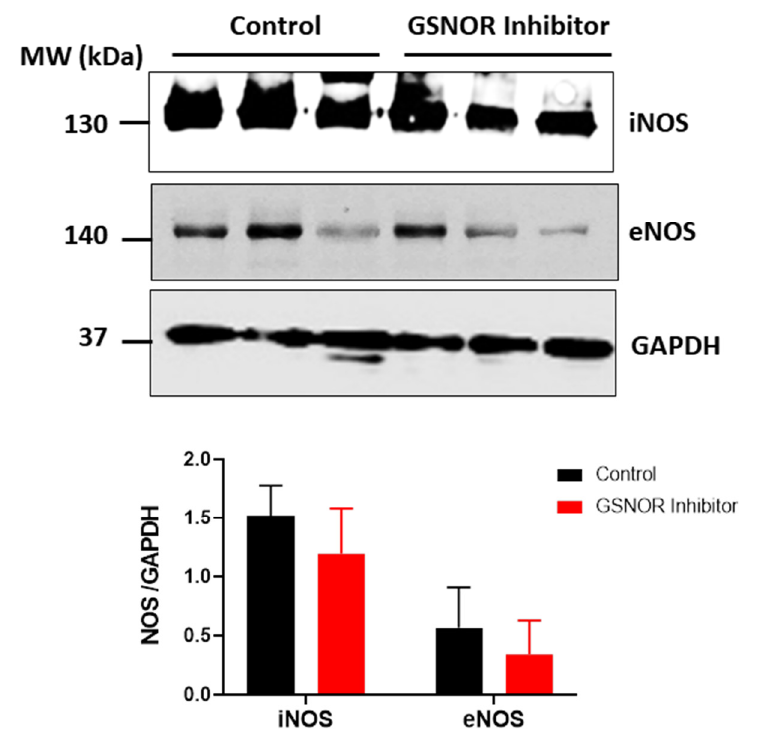
Figure 5. Expression of nitric oxide synthase (NOS) isoforms. Western blot analysis for the expression of inducible (iNOS) and endothelial (eNOS) NOS in the rat heart after ischemia–reperfusion. The panels show the levels of the NOS isoforms iNOS and eNOS in cardiac homogenates of rat hearts submitted to the ischemia–reperfusion protocol in the absence or presence of the GSNOR inhibitor C2 (1 µmol/L). Glyceraldehyde-3-phosphate dehydrogenase (GAPDH) was used as load control. Densitometric units of each corresponding isoform were normalized by the levels of GAPDH in each heart. n = 3 in each